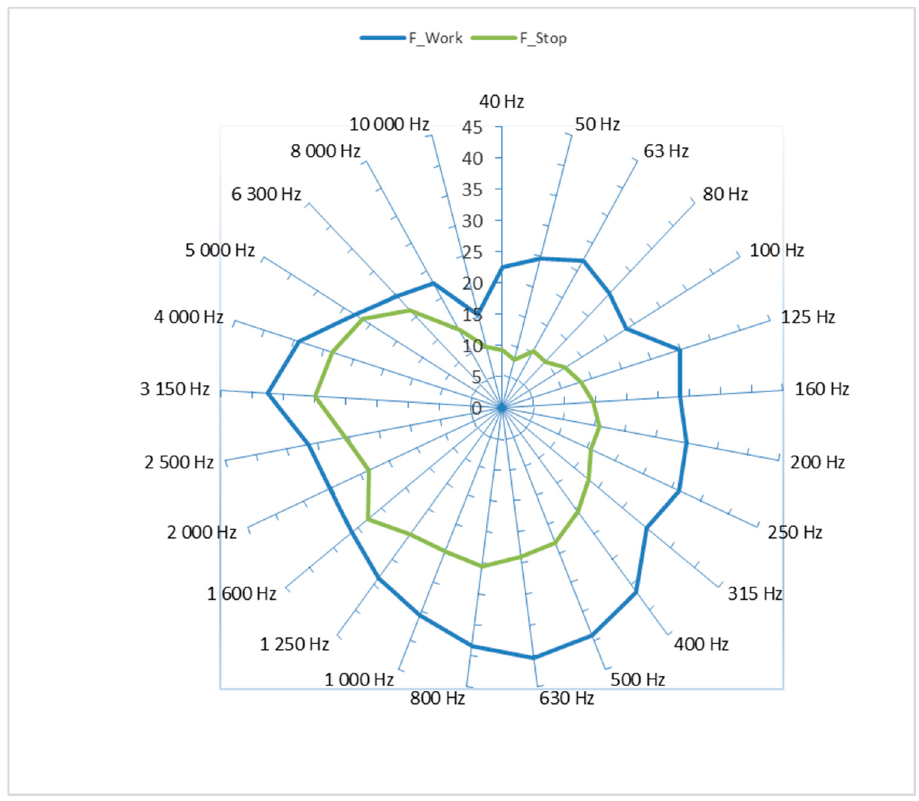
Figure 9. Values of noise emissions measured in residential areas I and II during operation (Work) and out of operation (Stop)—residential house—F. At certain frequencies (3150 Hz and higher), noise levels are equivalent to those reached during operation.